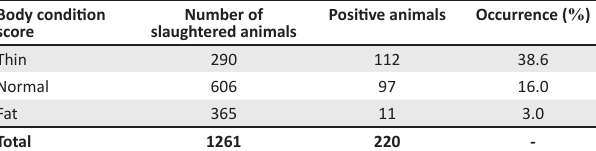
TABLE 4: Occurrence of foreign bodies in relation to body condition score.